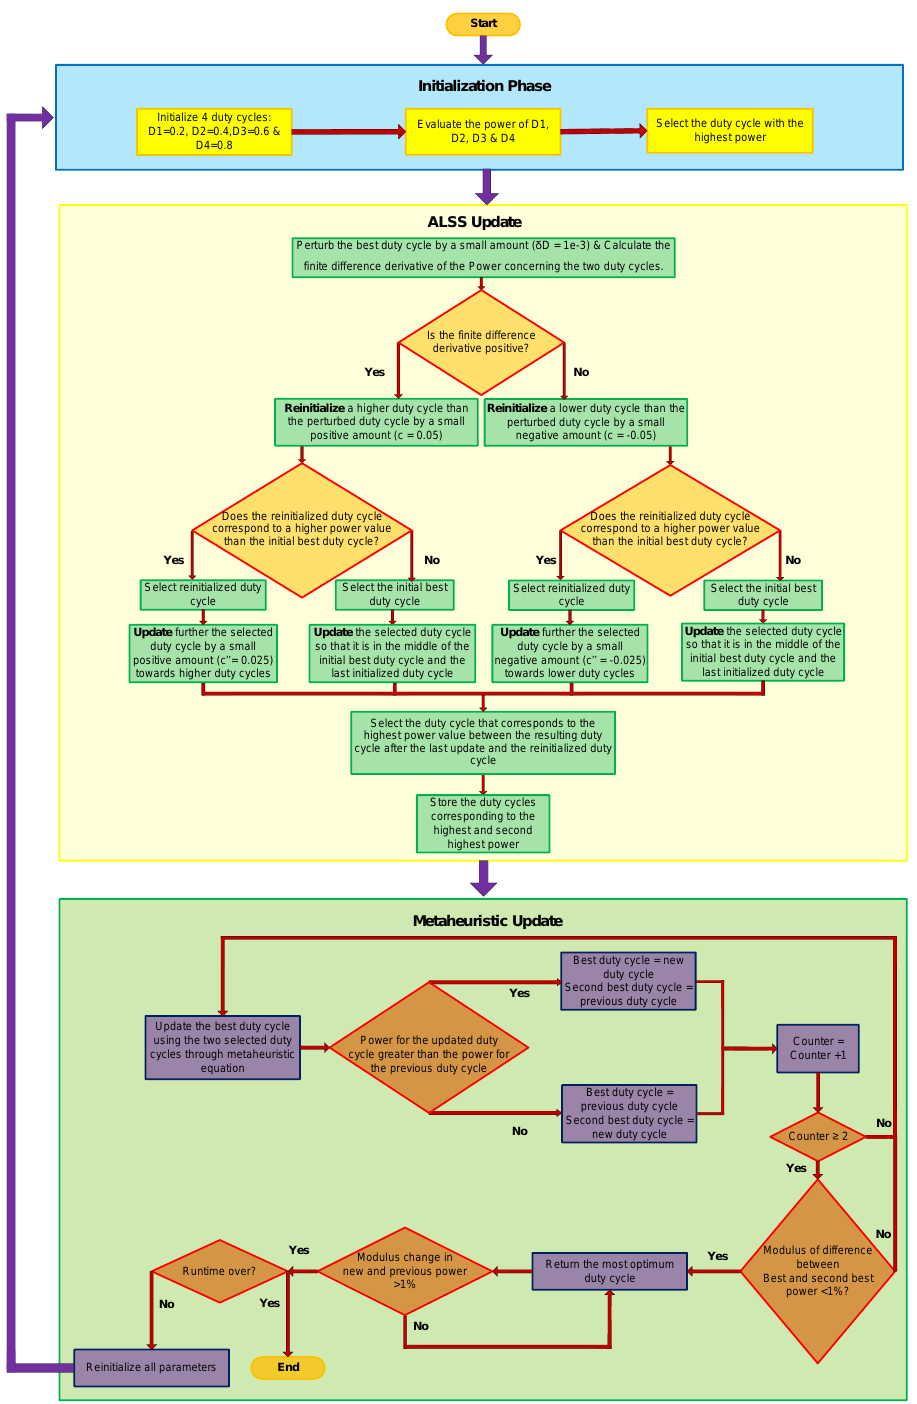
Figure 3. Flowchart explaining the implementation steps of the metaheuristic algorithm update using the